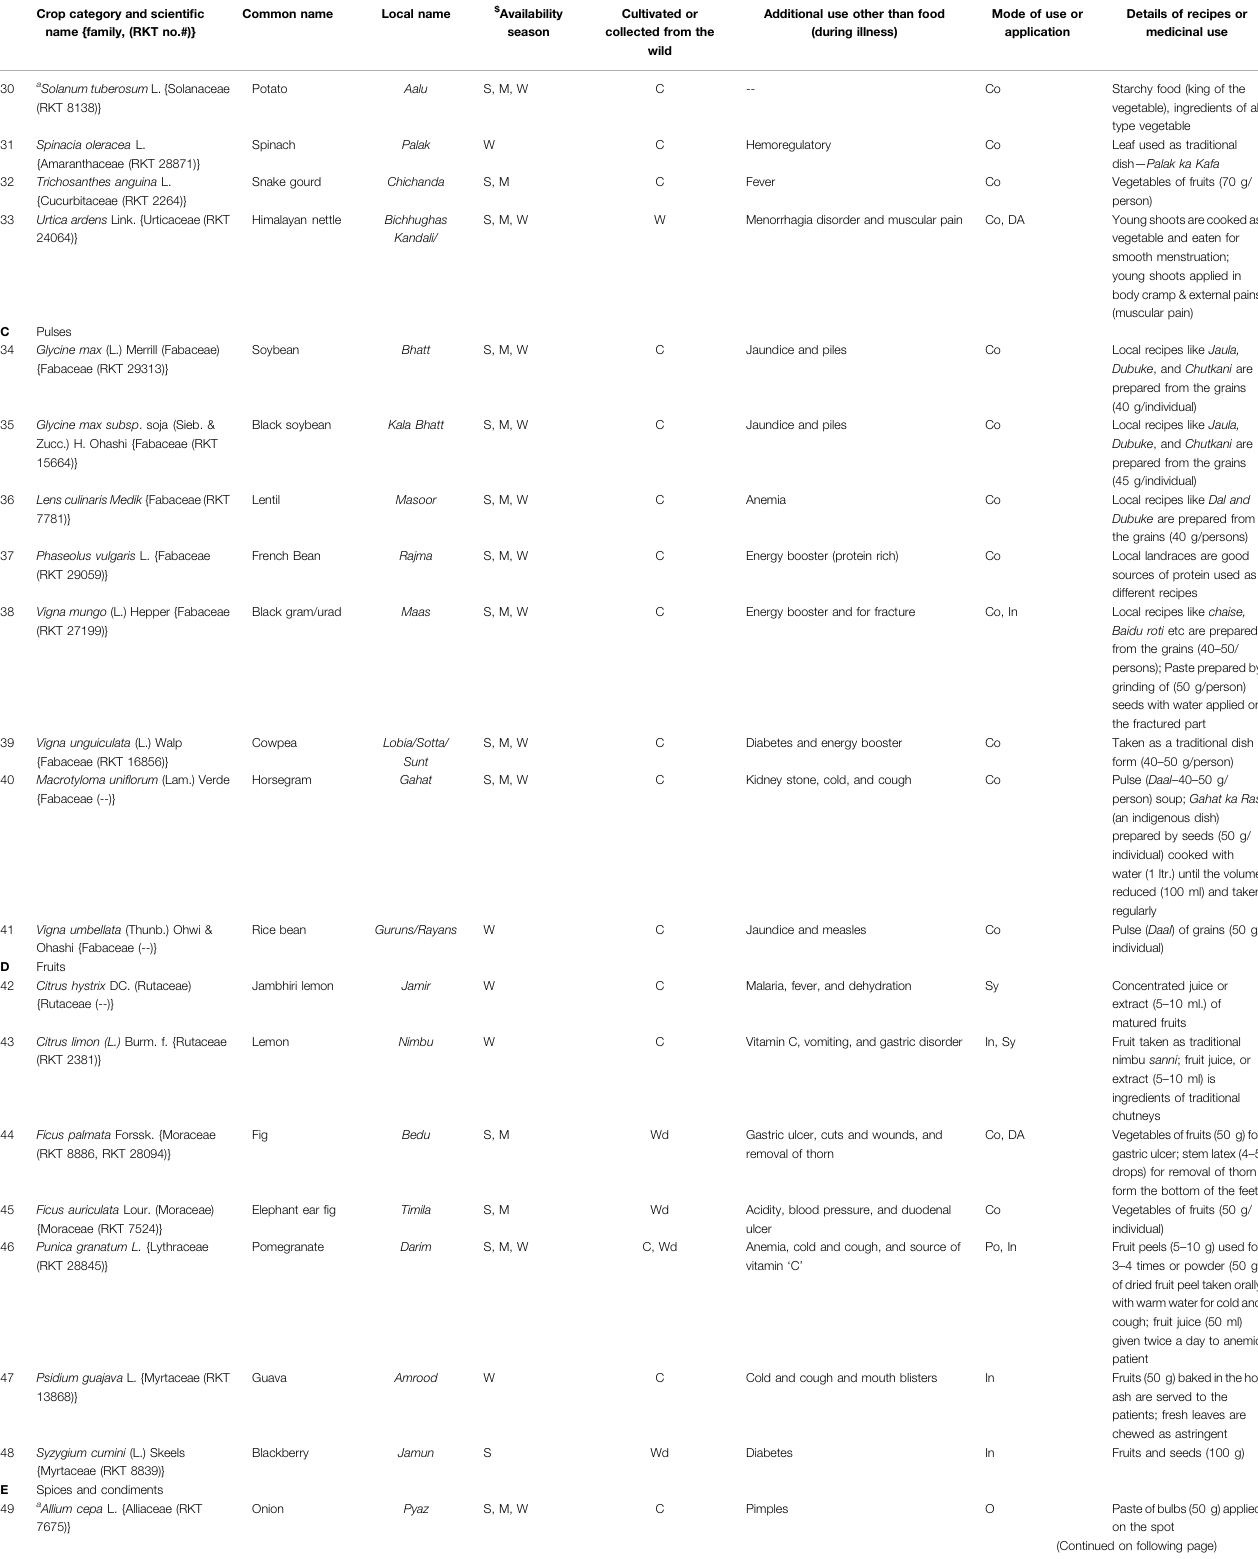
TABLE 1 | ( Continued ) Crops plants used as traditional foods, nutritional security, and primary healthcare by central Himalayan communities. Cropcategory and scienti fi c name {family, (RKT no.#)}